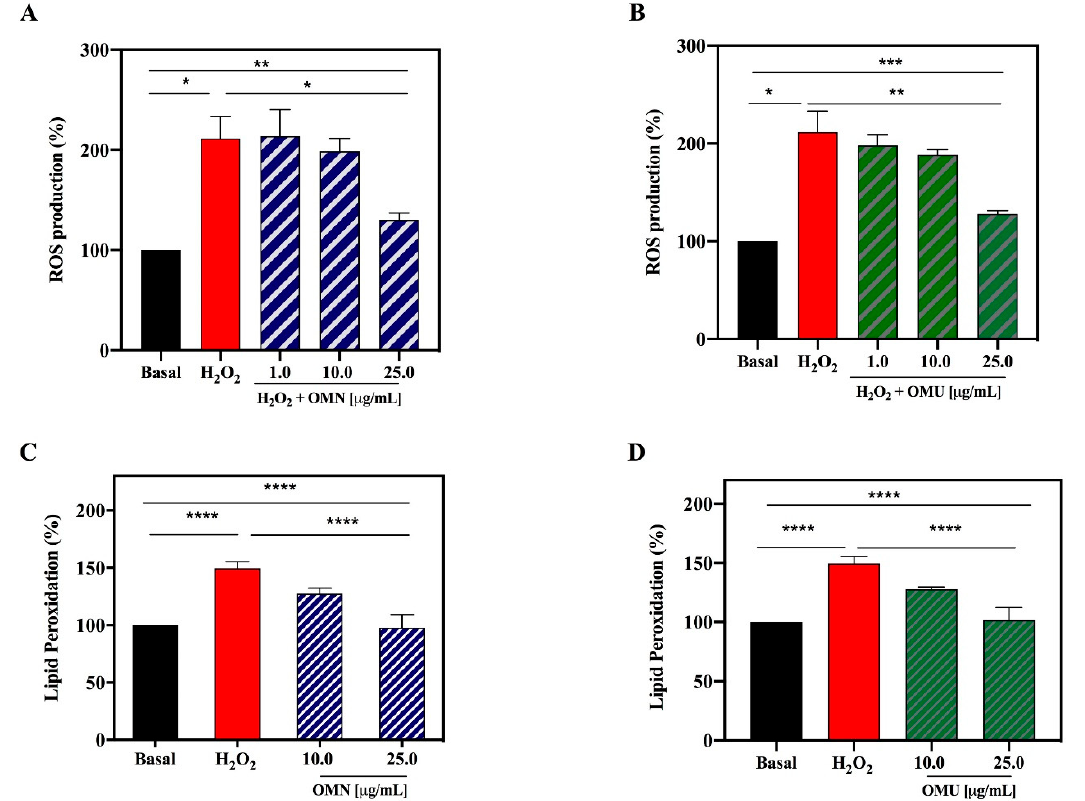
Figure 4. Antioxidant effects of OMN and OMU extracts on HepG2 cells. ( A ) OMN and ( B ) OMU reduce the H 2 O 2 (1 mM)-induced ROS levels in HepG2 cells. ( C ) OMN and ( D ) OMU decrease the lipid peroxidation in the same cells after oxidative stress induction by H 2 O 2 . Data represent the mean ± s.d. of six independent experiments performed in triplicate. All the data sets were analyzed by One-way ANOVA; basal vs H 2 O 2 samples were analyzed by t-student test, whereas H 2 O 2 vs OMN / OMU + H 2 O 2 samples by One-way ANOVA. (*) p < 0.5; (**) p < 0.01; (***) p < 0.001; (****) p < 0.0001.